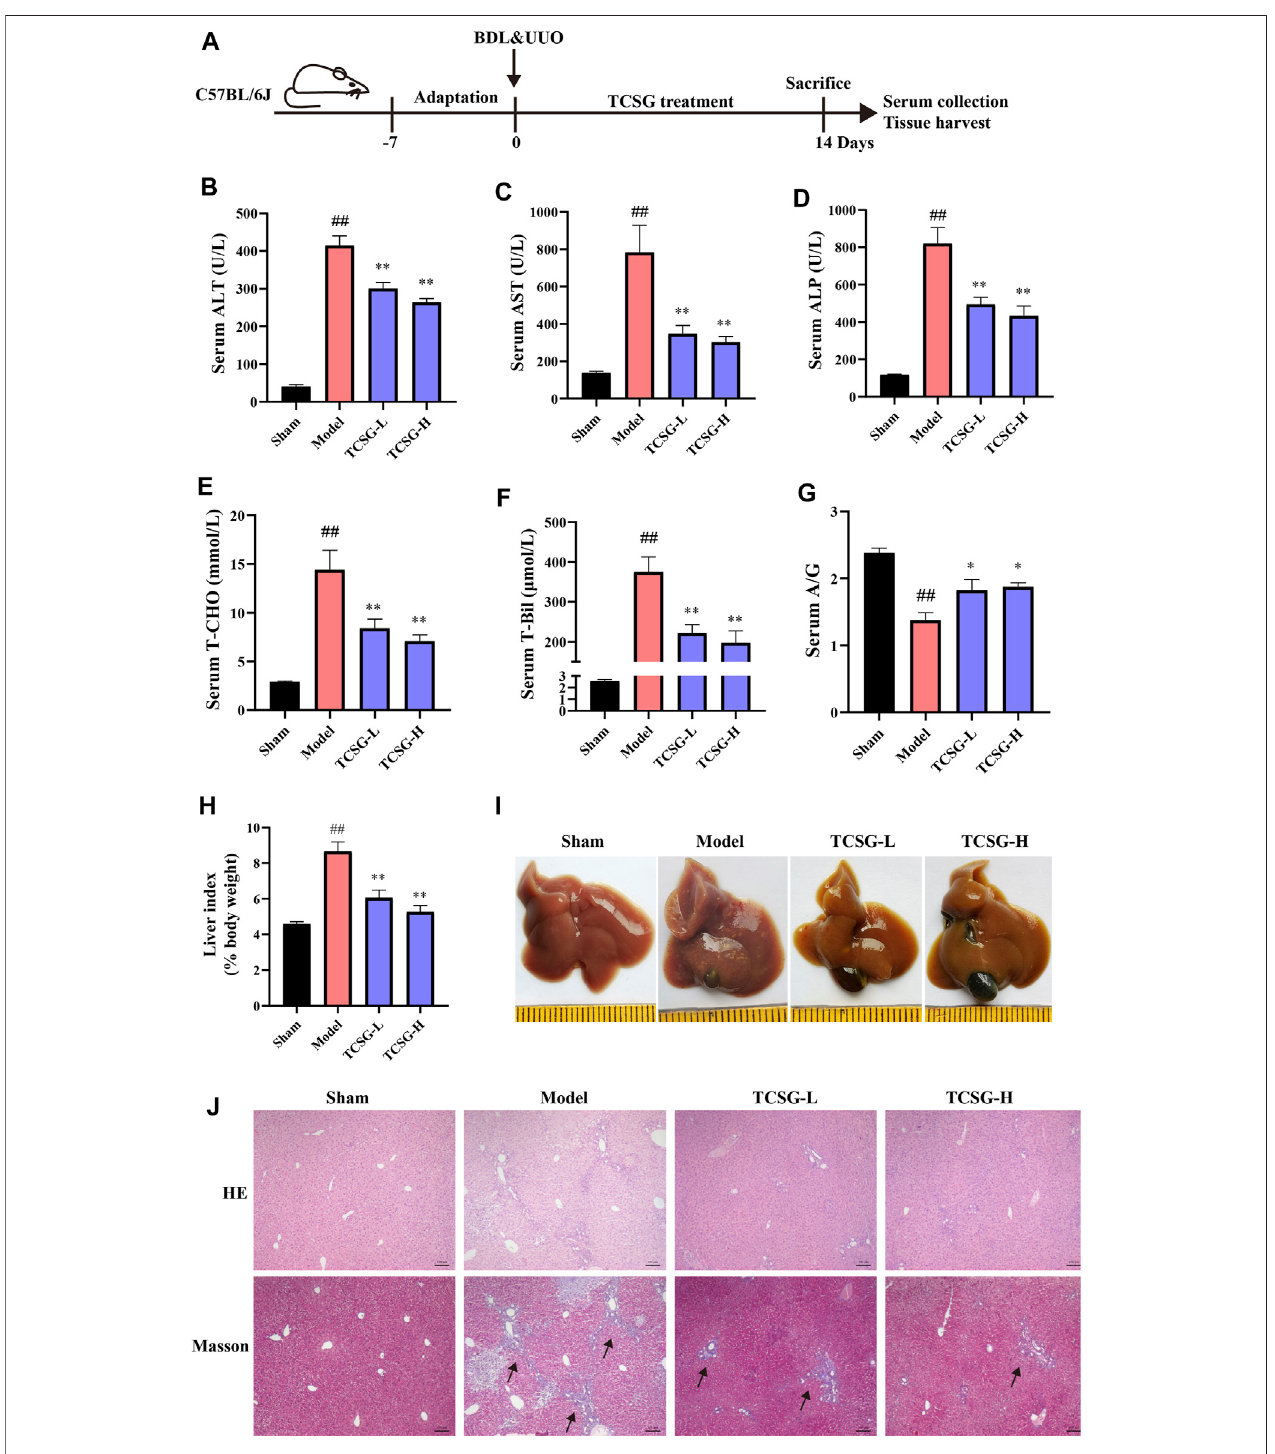
FIGURE1| TCSG from Baishouwu ameliorated liver damagein BDL&UUO mice. (A) Schematicdiagramofhepatic and renal fi brosismodel with TCSG treatment. After BDL&UUO operation, mice were treated with TCSG for consecutive 14 days, followed by sacri fi ce and tissues collection. (B – G) The effects of TCSG on serum biochemical measurements of liver injury. (H) The effects of TCSG on the liver index. (G) The effects of TCSG on the morphologic changes of the liver. (J) The effects of TCSGonliverpathologicalchangesdetectedbyHEstainingandlivercollagenaccumulationdeterminedbyMassonstaining(scalebar100 μ m).Dataareshownas means ± SEM ( n (cid:1) 10 – 12), ## p < 0.01, signi fi cantly different from sham group; * p < 0.05, ** p < 0.01, signi fi cantly different from model group.